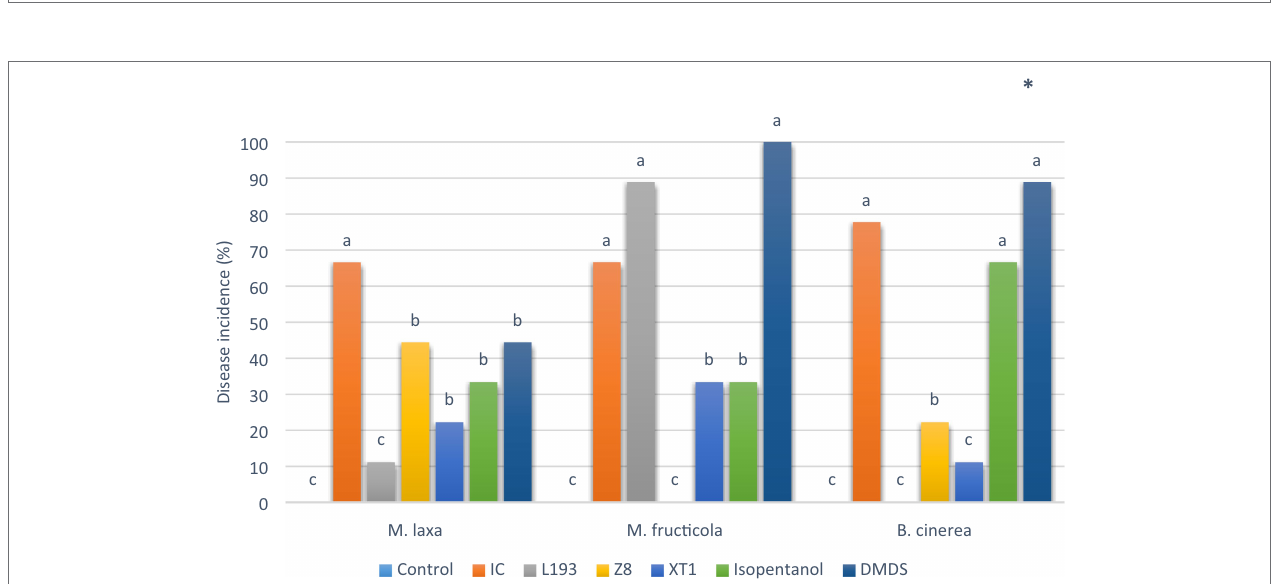
FIGURE 2 | In vitro fungal growth inhibition by bacterial volatile compounds produced by B. atrophaeus L193, B. velezensis XT1 and P. vulpis Z8 when cultured in MOLP medium using the bi-plate method.